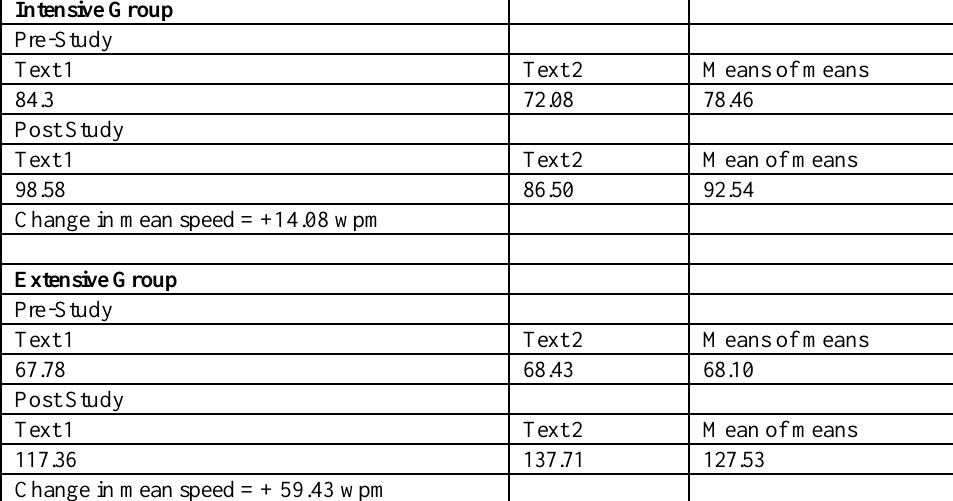
Table 4.5 Reading Speed: Comparison of Means Intensive